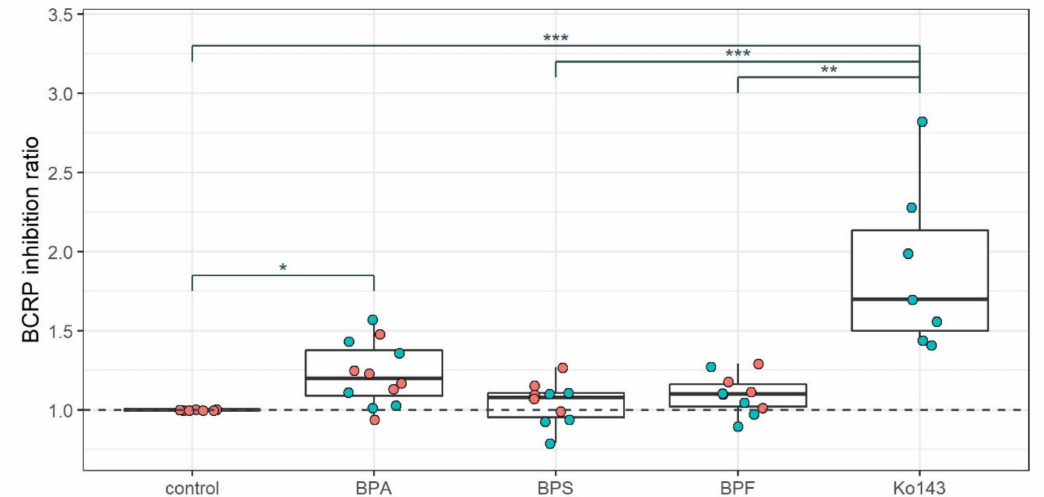
Figure 2. BCRP inhibition by bisphenols in the BBB model. BCRP inhibition = Intracellular Hoechst 33342 accumulation relative to control, where an increased signal indicates less transport of this fluorescent BCRP substrate out of the cells. Each dot represents relative Hoechst accumulation, and the overlying box plots depict median value and the interquartile range (IQR) plus whiskers up to the lowest/highest value < 1.5 × IQR. Pink = 8–10 days exposure; blue = 2 h exposure. Data stems from 7 different experiments, all using protocol 1 or 2. Not all experiments contained both treatment times or all treatments. n (Ko143) = 7, n (BPA) = 12, n (BPS) = 10, n (BPF) = 10. Ko143 = known BCRP inhibitor. * = p < 0.05, ** = p < 0.01, *** = p < 0.001 indicate statistical significance, obtained with the Kruskal–Wallis test and Dunn’s post-hoc test using FDR correction for multiple